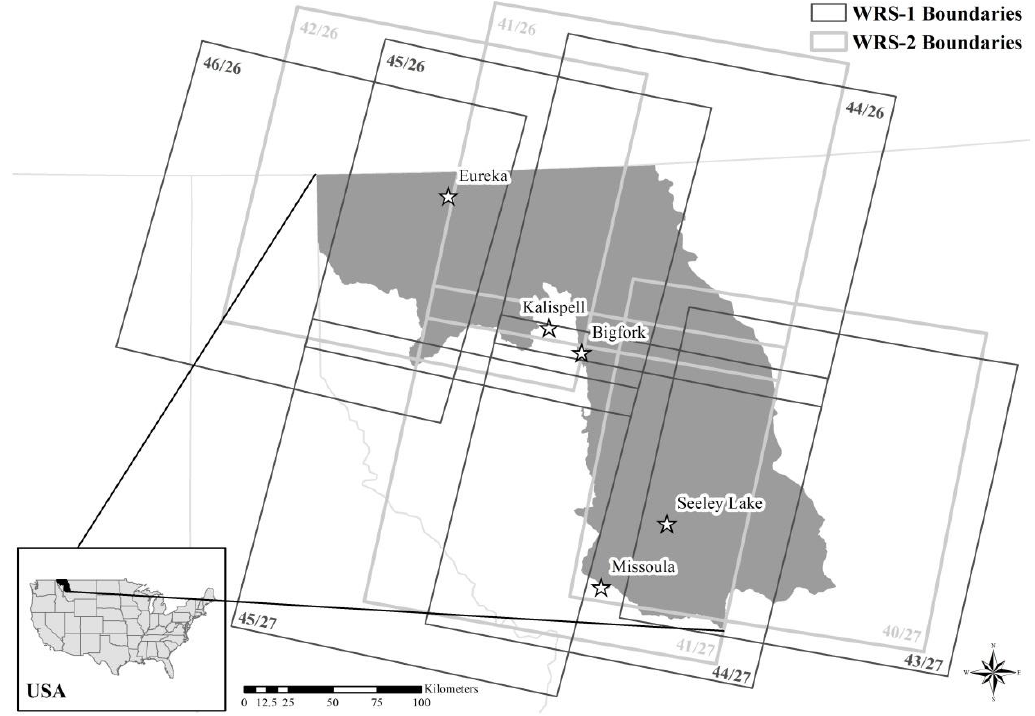
Figure 1. Location map for the study area within Montana, USA. Boundaries of WRS-1 (MSS) scenes and WRS-2 (TM, ETM+, and OLI) scenes are shown over the study area. Scene boundaries are labeled as path/row.